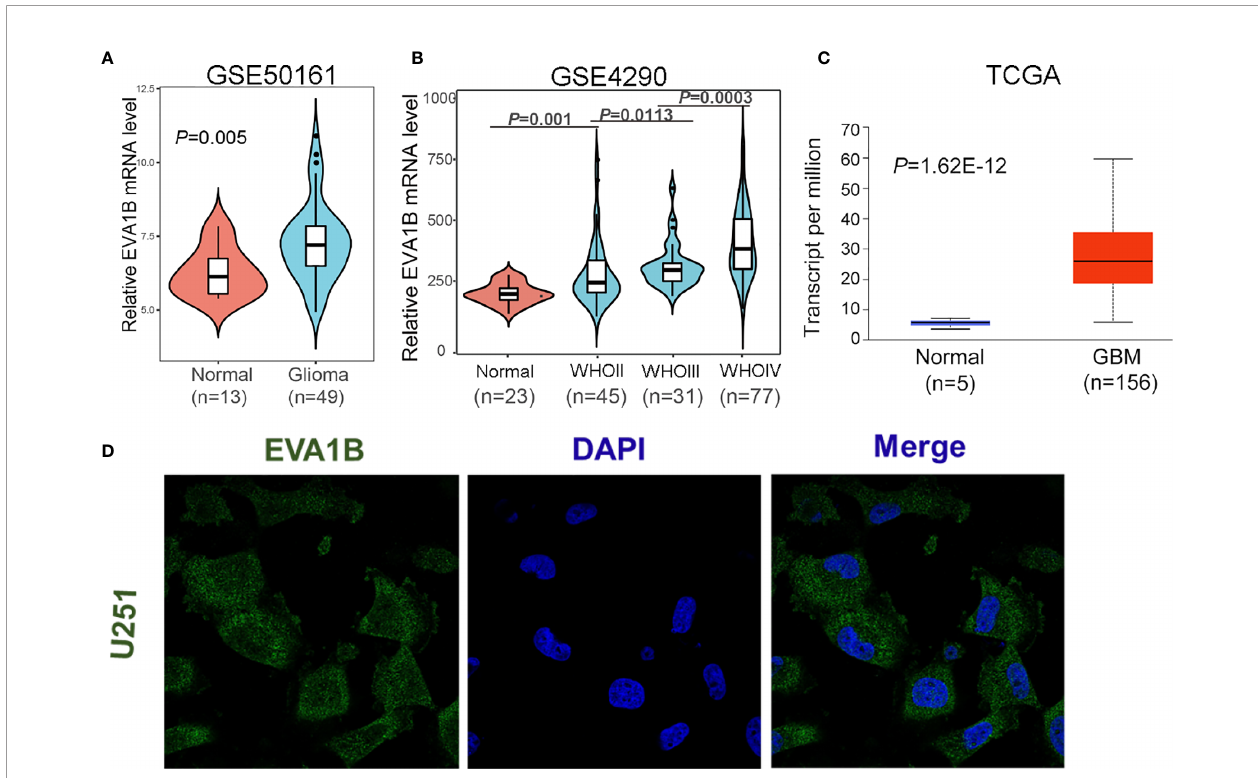
FIGURE 1 | The expression of EVA1B is highly expressed in glioma compared to the normal brain tissues. (A – C) The EVA1B expression is signi fi cantly regulated in glioma in the GSE50161, GSE4290, and TCGA, and increases with tumor grade. (D) The EVA1B protein is predominantly localized in the cytoplasm and cellular membrane of U251 (images obtained from the Human Protein